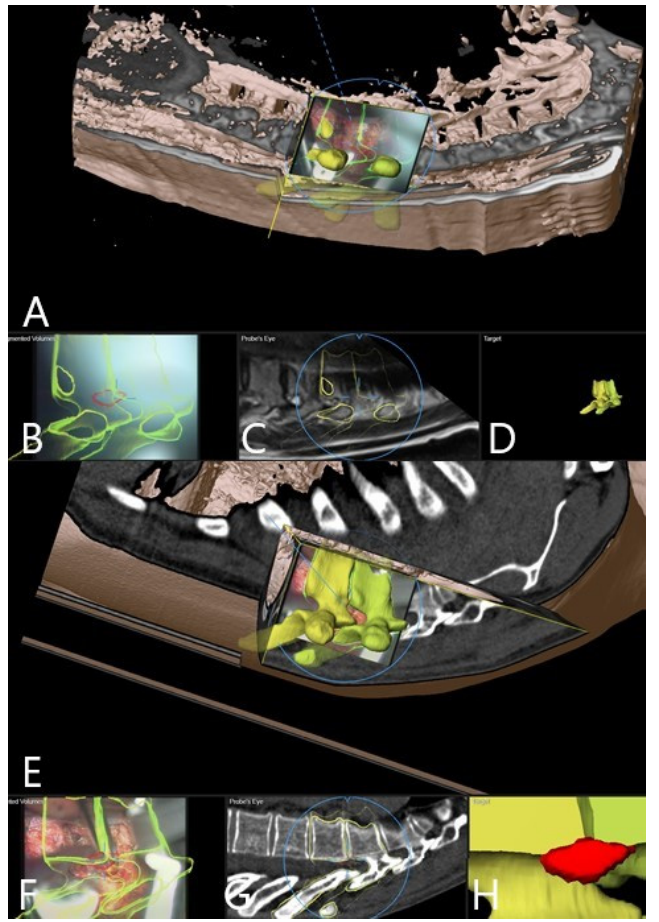
Figure 2. A 62 year old female patient (patient no.10) with herniated thoracic disc Th 7/8, operation via a left lateral transpleural approach. ( A ) Overview visualization depicting the position of the microscope view in relation to the segmented vertebra, visualized in yellow color. ( B ) AR visualization with the outline of vertebra bodies T7 and T8 and herniated disc in red. ( C ) Probe’s-eye view with segmented structures in the MRI. ( D ) Segmented objects visualized separately in the target view. ( E ) Overview visualization depicting the microscope view position related to segmented vertebra. ( F ) AR visualization with the outline of vertebra bodies T7 and T8 and herniated disc in red after placement of spinal retractor. ( G ) Probe’s-eye view with segmented structures in the intraoperative CT. ( H ) Target